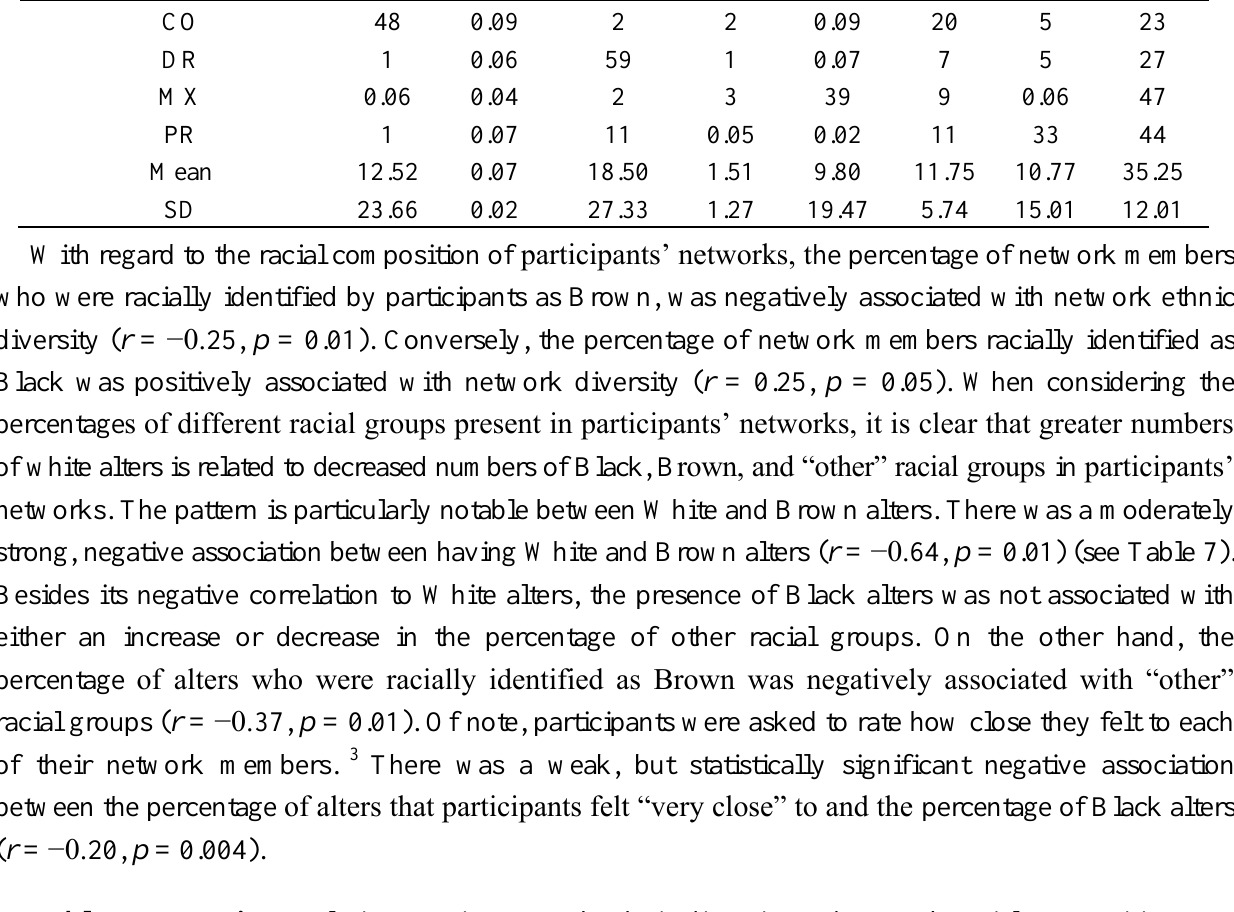
Table 7. Pearson’s correlation matrix: network ethnic diversity and network racial composition.